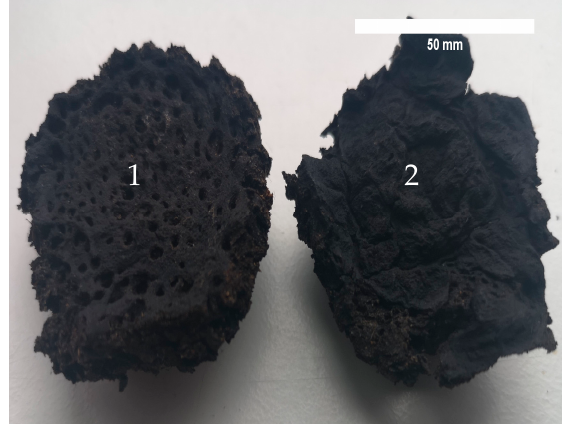
Figure 4. View of the hardened sapropel: 1—not activated; 2—activated for 3 min.